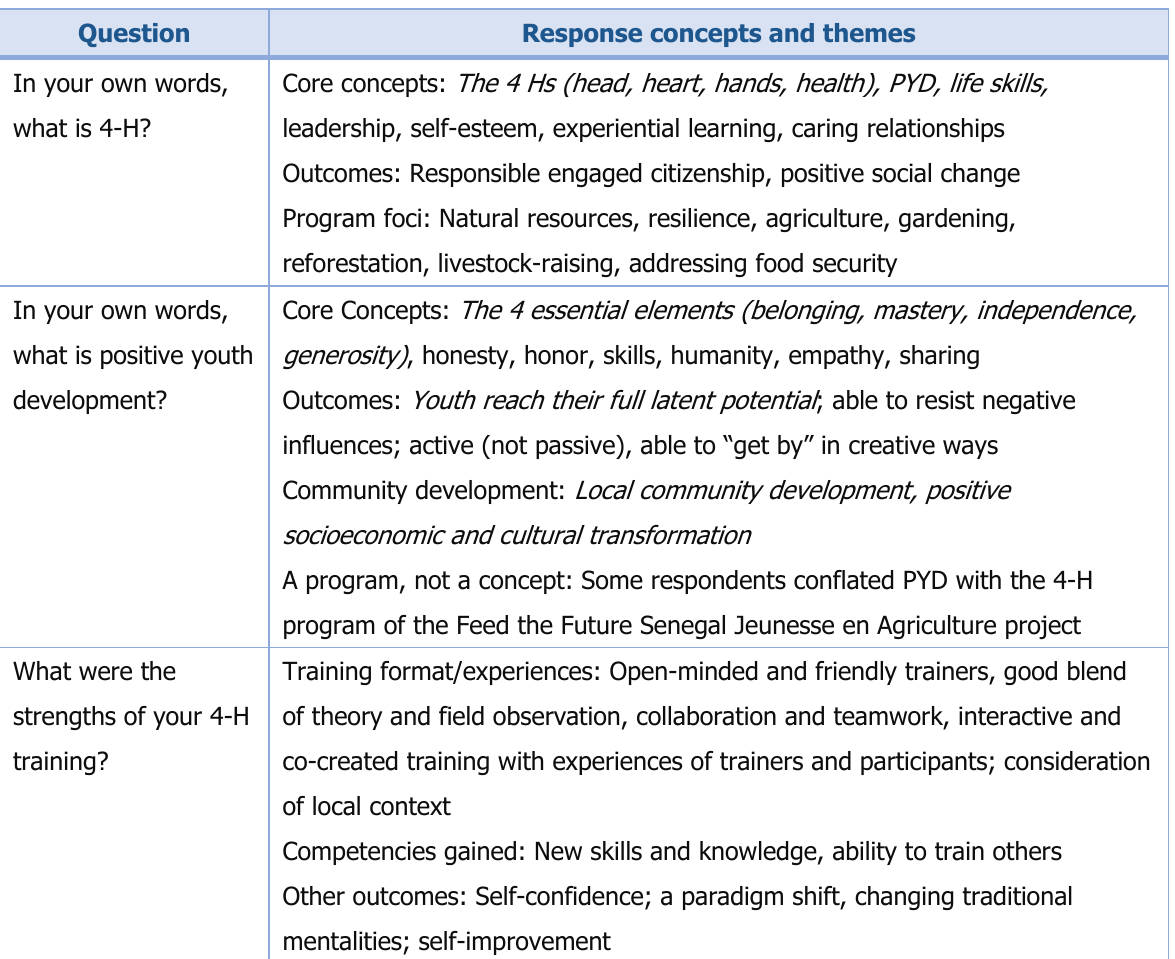
Table 1. Response Concepts and Themes From the 4-H Senegal Adult Leader Survey